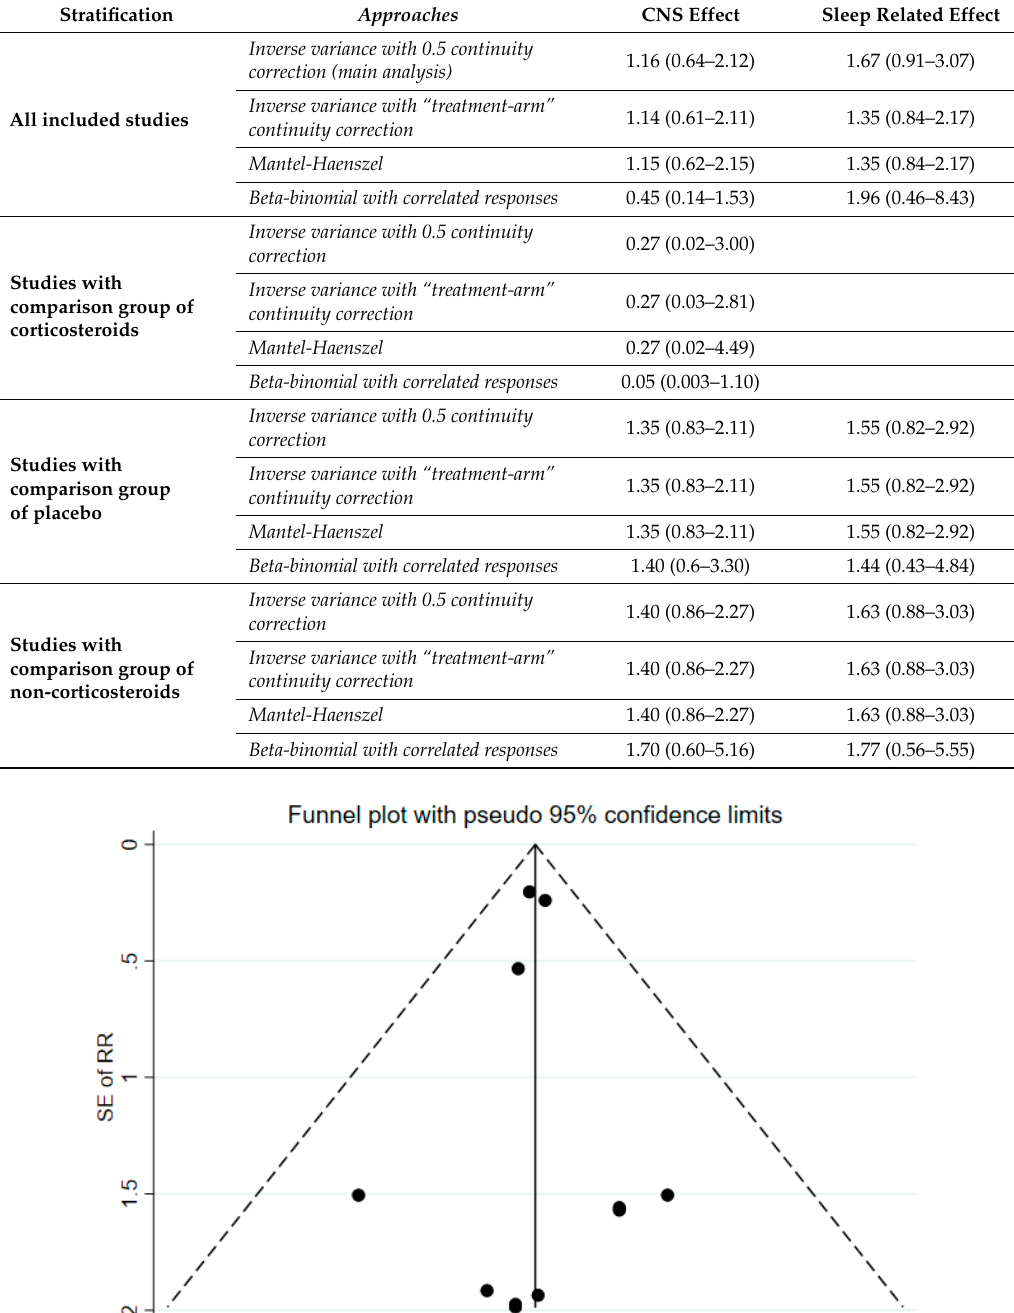
Table A2. Pooled risk ratios in the main and sensitivity analyses.